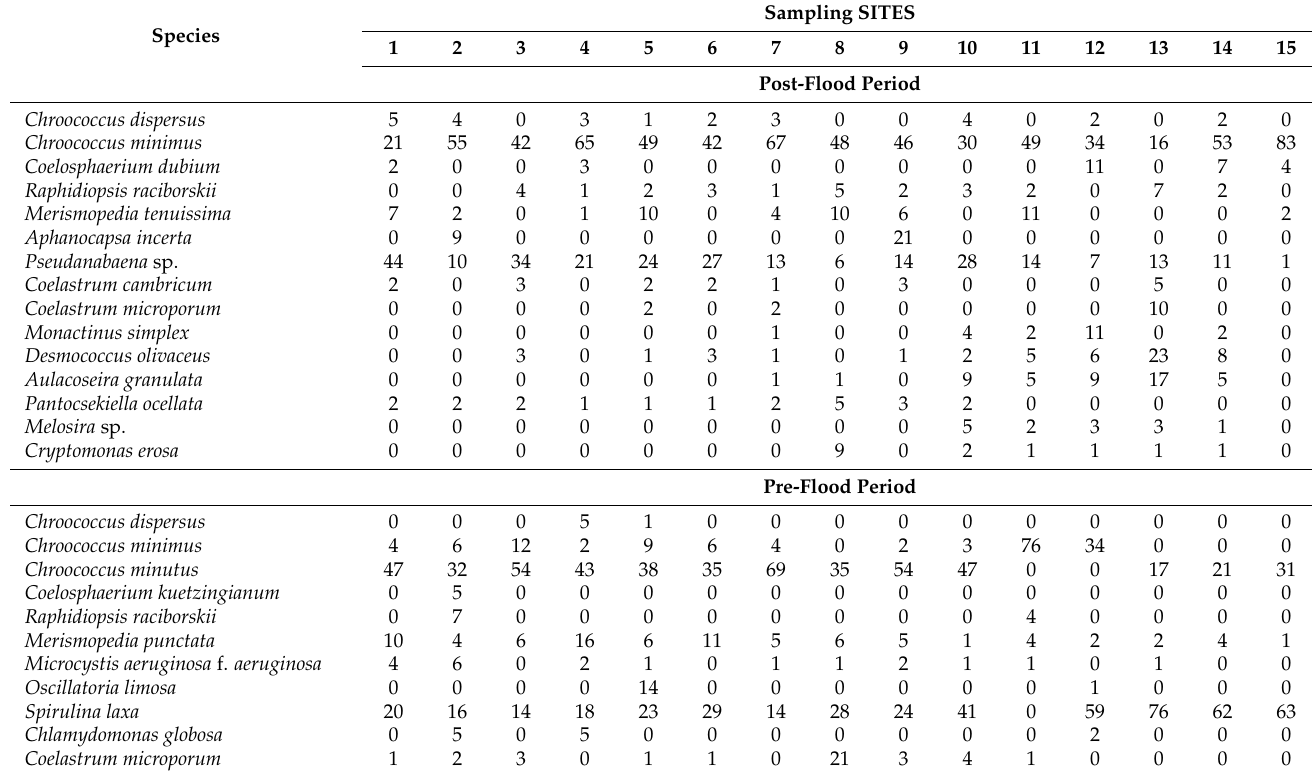
Table 6. Dominant phytoplankton species (relative density, %) in the post- and pre-flood periods at sites 1–15.